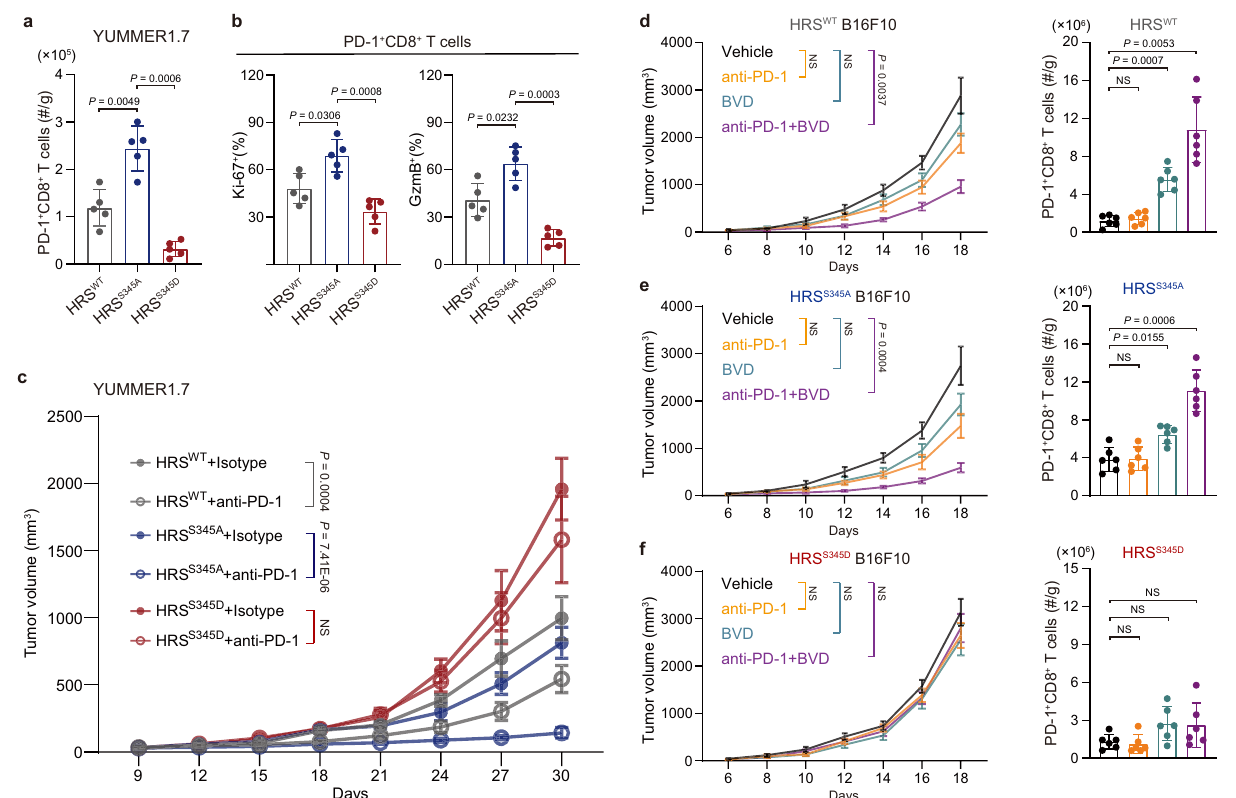
Fig. 2 HRS S345 phosphorylation blocks CD8 + T cell in fi ltration and reduces the ef fi ciency of anti-PD-1 treatment in mice. a Bar graphs showing the numbers of intratumor PD-1 + CD8 + TILs (normalized to tumor weights) isolated from the YUMMER1.7 tumors expressing different HRS variants ( n = 5). b Percentages of Ki-67 + (left) and Granzyme B + (right) cells of PD-1 + CD8 + T cells in YUMMER1.7 tumors ( n = 5). c Growth of different HRS-expressing YUMMER1.7 tumors in C57BL/6 mice treated with anti-PD-1 or isotype control antibodies ( n = 5). d – f Growth of B16F10 tumors expressing HRS WT ( d , left), HRS S345A ( e , left), or HRS S345D ( f , left) treated with vehicle, anti-PD-1, BVD-523 (BVD), or anti-PD-1 plus BVD-523 as indicated. The numbers of PD-1 + CD8 + TILs (normalized to tumor weights) were shown in right ( n = 6). The experiments were repeated three times independently with similar results obtained ( a – f ). Data represent mean ± s.d. Statistical analyses were performed using one-way ANOVA ( a , b , d right, e right, f right) or two-way ANOVA ( c , d left, e left, f left). Tukey ’ s test was used following ANOVA. Source data are provided as a Source Data fi